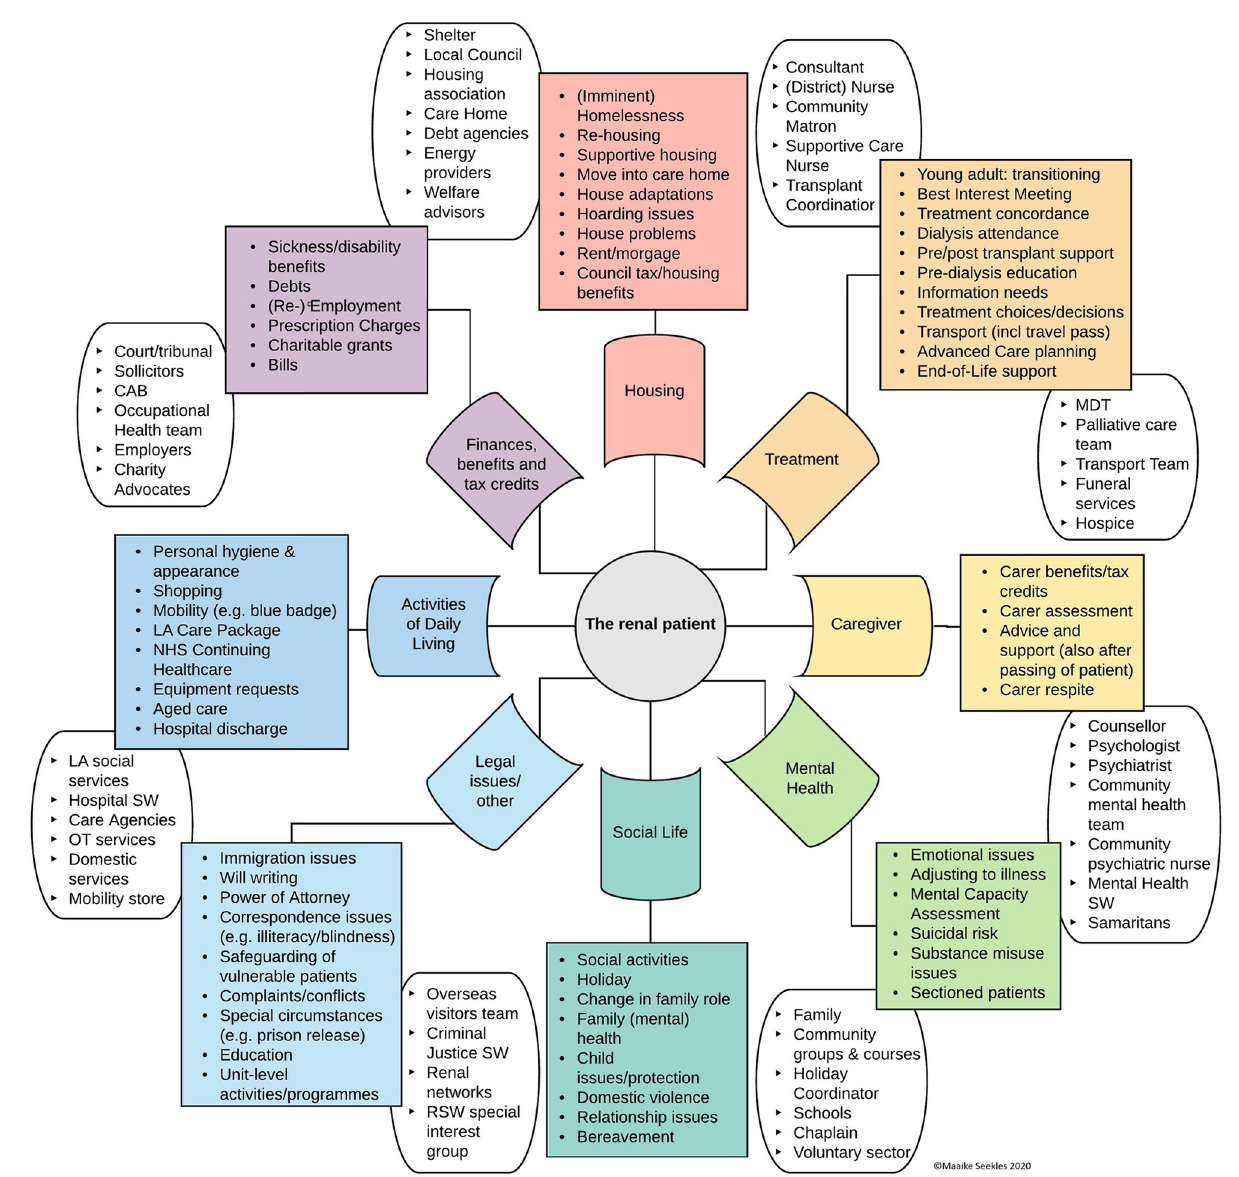
Fig 1. The scope of renal social work: Patient issues and interacting